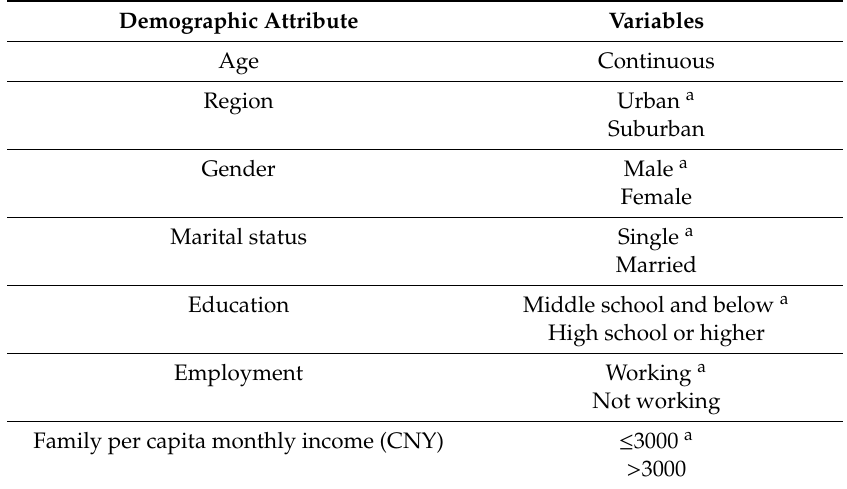
Table A2. Variables for the sociodemographic